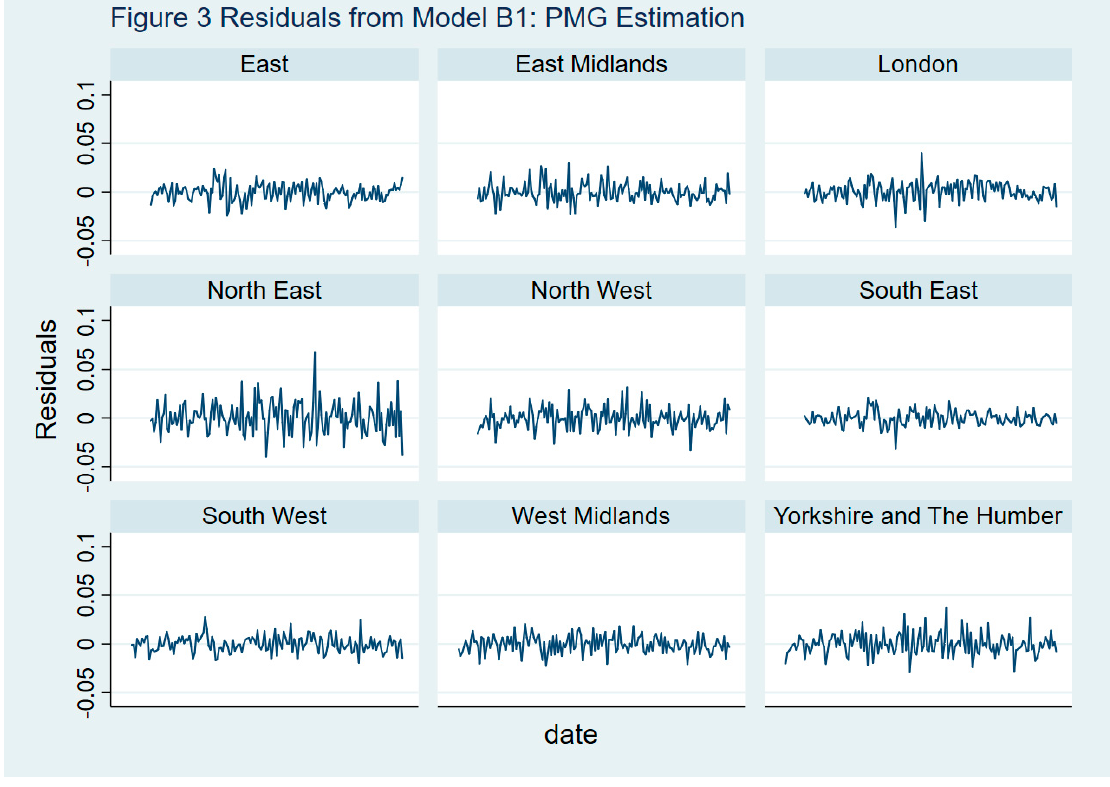
Figure 3. Residuals for regions from Model B1, pooled mean group (PMG) estimation.